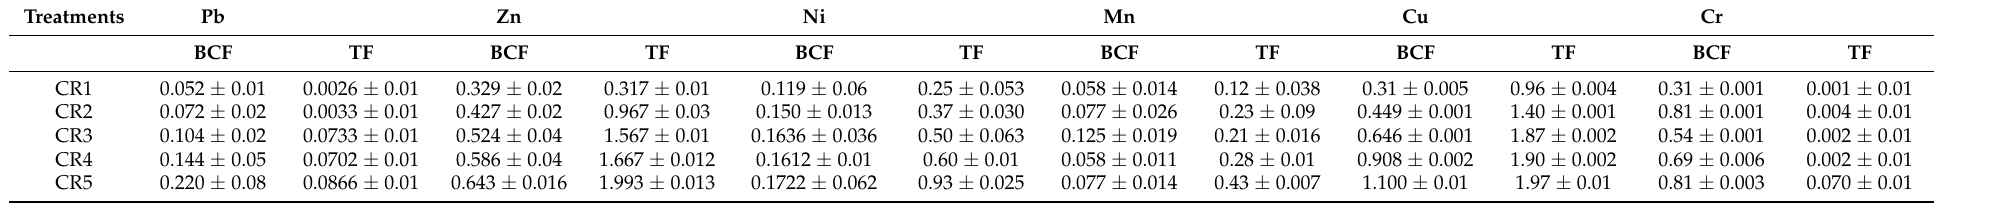
Table 2. Bioconcentration factor (BCF) and translocation factor (TF) of heavy metals in C. cajan -remediated soil.